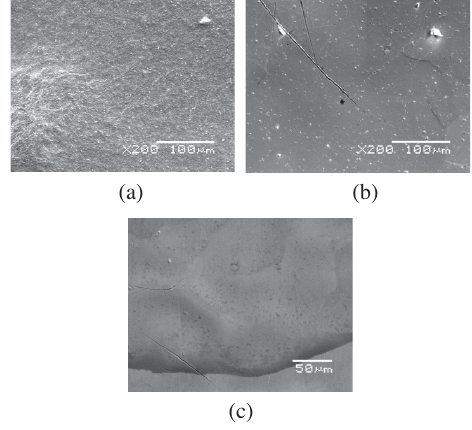
FIG. 8. Scanning electron microscope images of pure (a) and diluted Aquadag ® on Nb substrate. The dilution factor has been calculated as the ratio of H 2 O mass to Aquadag mass. Parts (b) and (c) respectively show Aquadag diluted by factors of 100 and 2 × 10 4